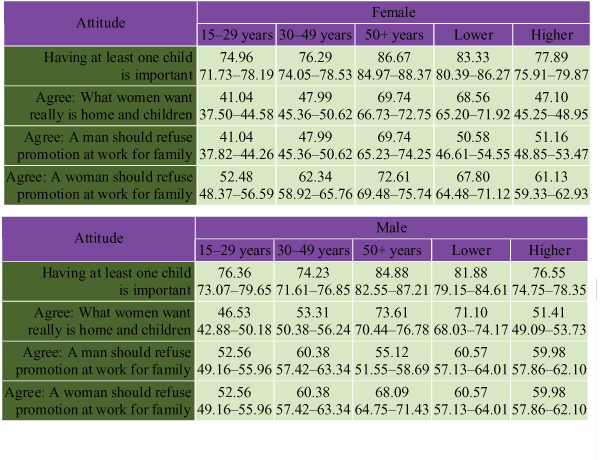
Distribution of Attitude/Values by Age and Education. Data Source: GSS Cycle 10, 1995